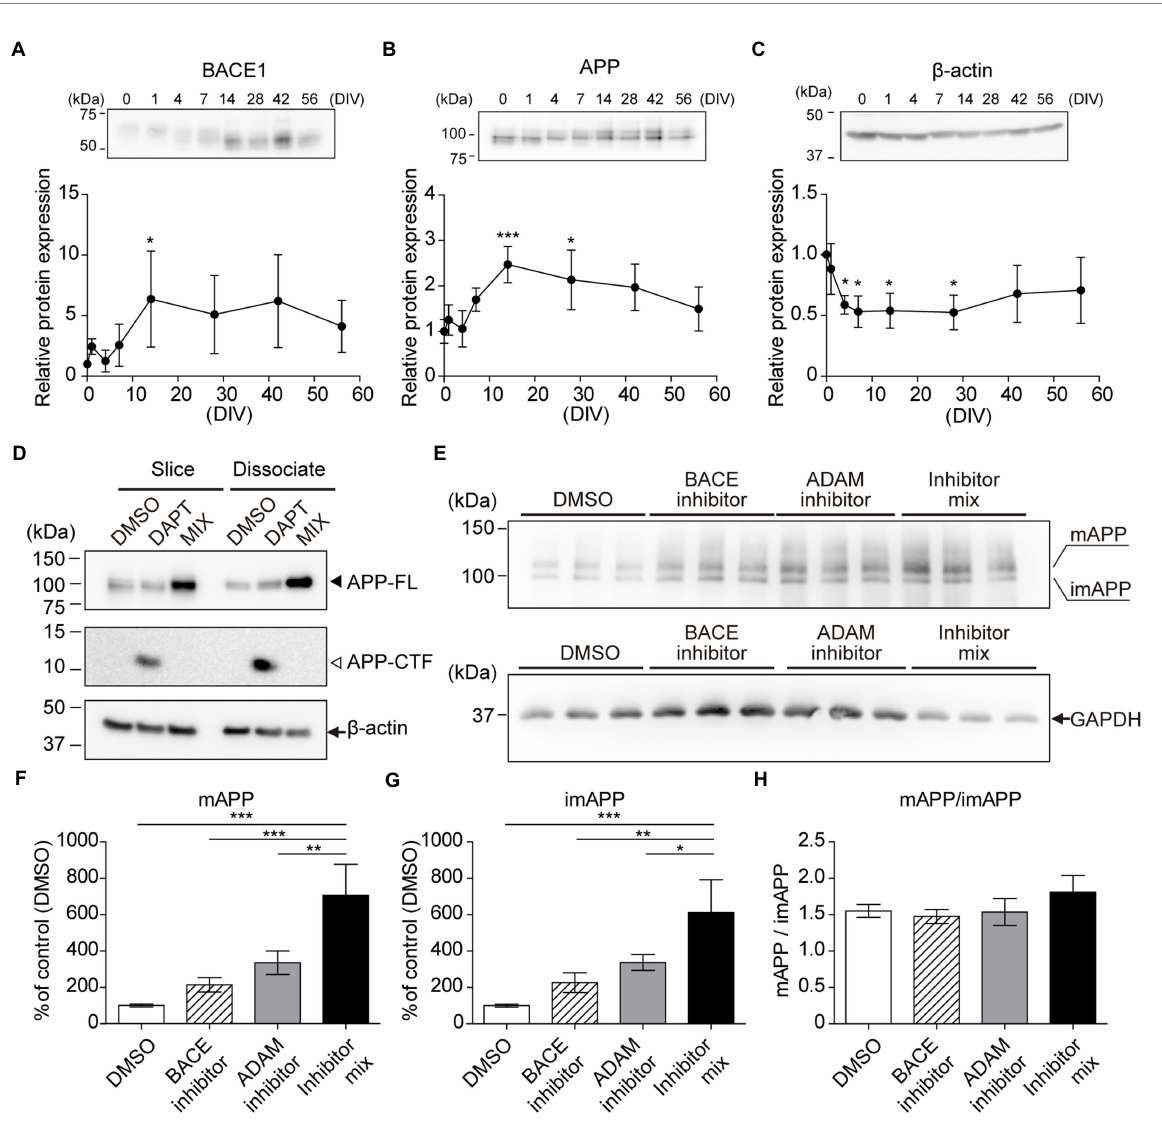
(Figure 4B). Further analysis showed that the ratio of A β 40 secretion to total protein amount was 1.7 to 2.8 pg/ μ g for 24 h (Figure 4C). There was no significant difference in A β 40 secretion between groups ( p > 0.05). To assess the incubation time for the A β 40 assay, we cultured four hippocampal slices for 1–90 h with fresh SCM after